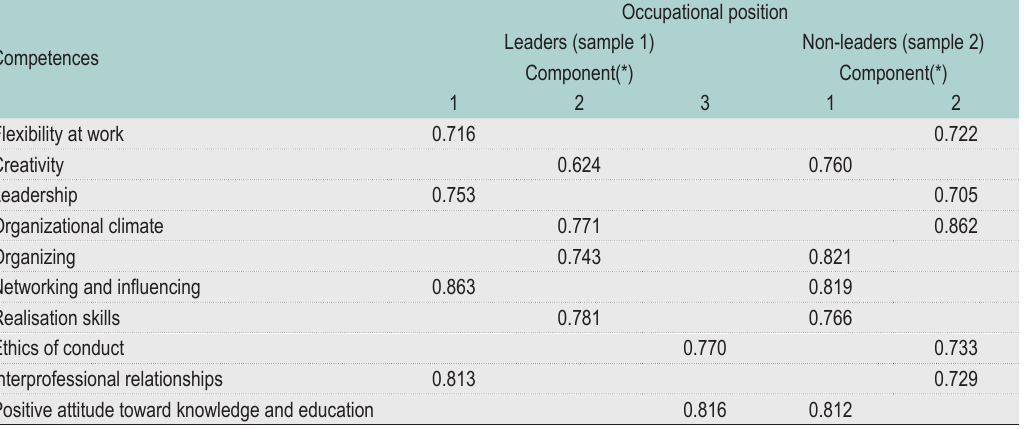
(*) Extraction Method: Principal Component Analysis; Rotation Method: Varimax with Kaiser